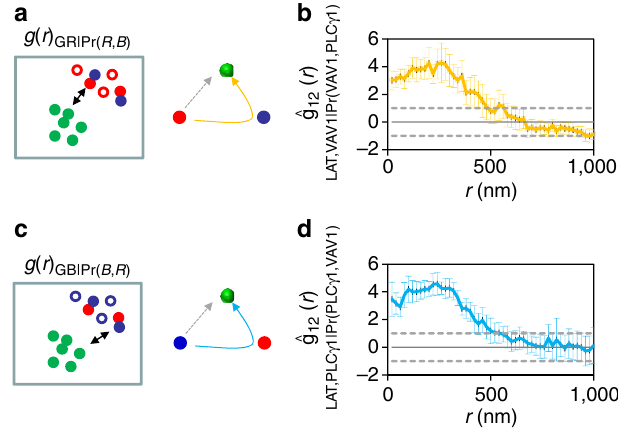
Figure 3 | Mutually synergic recruitment of effector proteins to LAT clusters. ( a , left) A scheme depicting the analyses of interaction synergy between molecules of three types. Red molecules are selected based on their proximity to blue molecules (selected molecules are marked with filled circles while unselected molecules are marked with empty circles). (right) A scheme of molecular interactions, summarizing the hierarchical pattern of molecular interactions under study by the statistics on left. Yellow arrow indicates synergic binding, while dotted grey arrow mark direct binding. ( b ) A conditional bivariate PCF analysing the synergic interaction of VAV1 and PLC g 1 upon the binding of VAV1 to LAT. A conditional bivariate PCF was first generated for the selected set with respect to green molecules (see definition in equation (6) in Supplementary Information). The PCF was compared with PCFs due to the 19 random sets generated by Monte-Carlo simulations. The conditional biavariate PCFs were standardized and averaged for multiple cells ( n ¼ 13, same samples used in c , we further refer to this curve as a standardized conditional bivariate PCF. See equations (7–10) in Supplementary Information for definition). The flat dotted lines mark the 95% confidence interval due to the Monte-Carlo simulations. The portion of the PCF (in yellow) above the dotted lines indicates significant interaction synergy at lower r values. ( c , left) A scheme depicting the analyses of interaction synergy between molecules of three types, namely the recruitment of blue molecules to green molecules through binding to red molecules (filled blue circles mark selected molecules). (right) A scheme of molecular interactions, summarizing the hierarchical pattern of molecular interactions under study in the statistics on left. Cyan arrow indicates synergic binding while dotted grey arrow mark direct binding. ( d ) A conditional bivariate PCF analysing the interaction synergy of PLC g 1 and VAV1 upon the binding of PLC g 1 to LAT. The portion of the curve (in cyan) above the dotted lines indicates significant interaction synergy. Error bars are